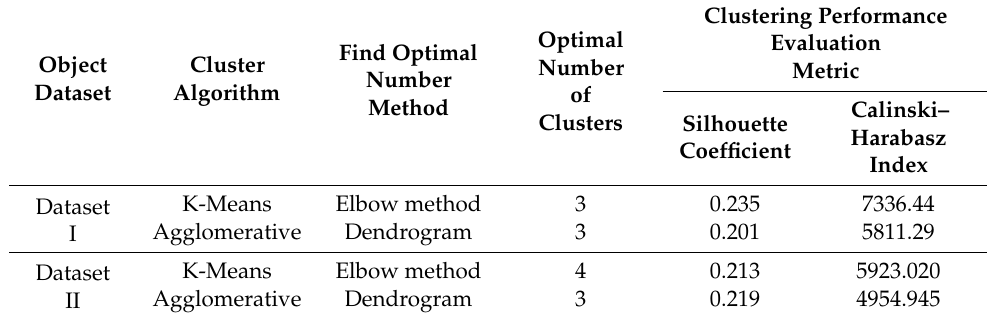
Table 4. Clustering algorithm performance evaluation on the investigation